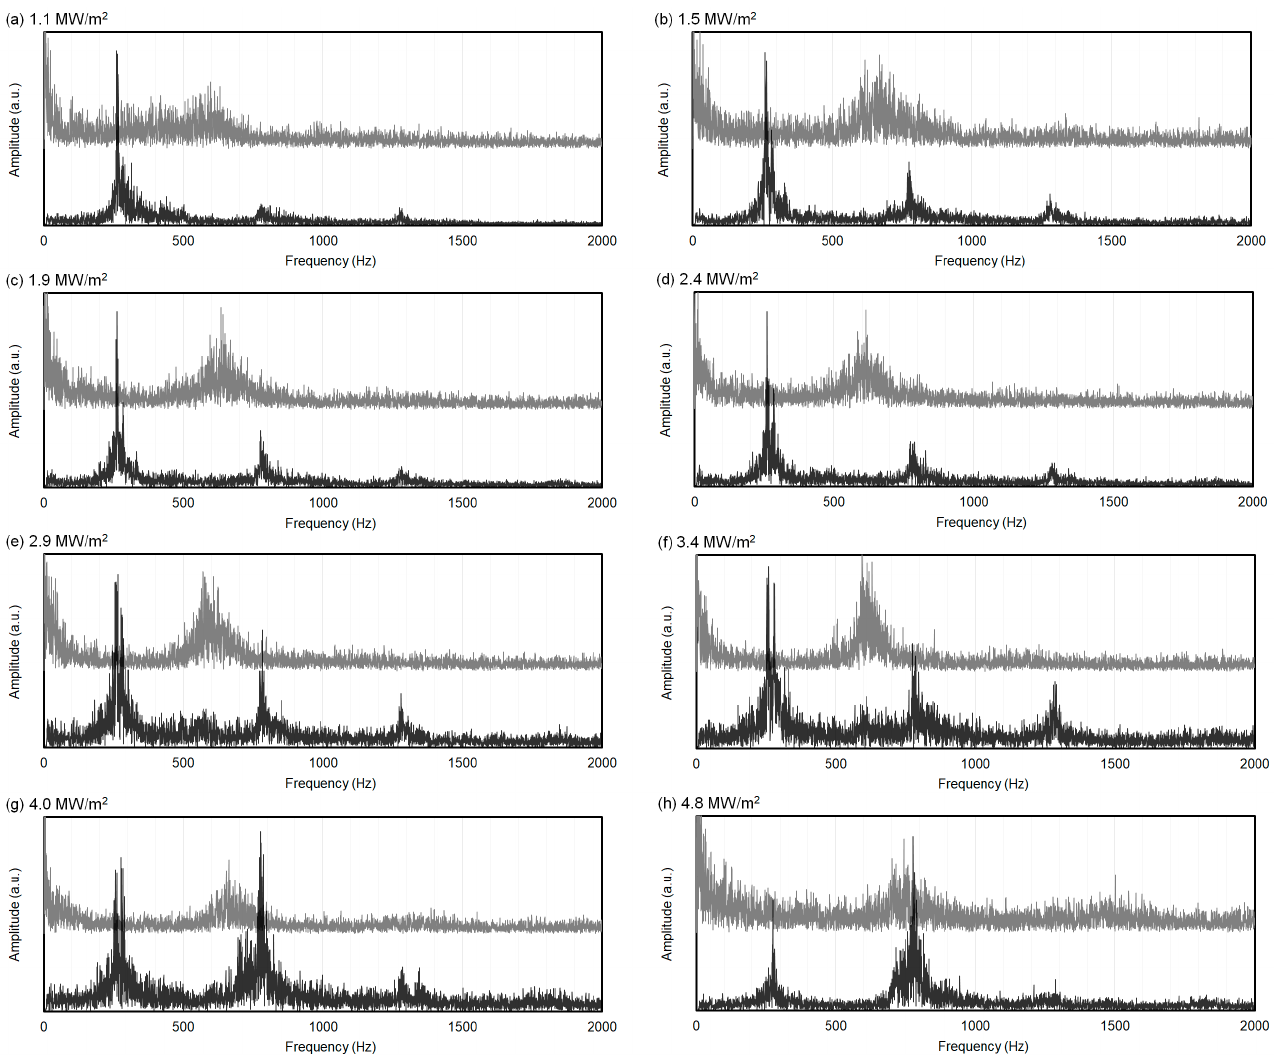
Figure 4. Spectra acquired using a synchronized signal with a high-speed camera and a hydrophone. The black line in each pair is the hydrophone spectrum, and the grey line is the spectrum of the motion of the vibration plate. The spectra were acquired at heat fluxes of ( a ) 1.1 MW/m 2 , ( b ) 1.5 MW/m 2 , ( c ) 1.9 MW/m 2 , ( d ) 2.4 MW/m 2 , ( e ) 2.9 MW/m 2 , ( f ) 3.4 MW/m 2 , ( g ) 4.0 MW/m 2 , and ( h ) 4.8 MW/m 2 .